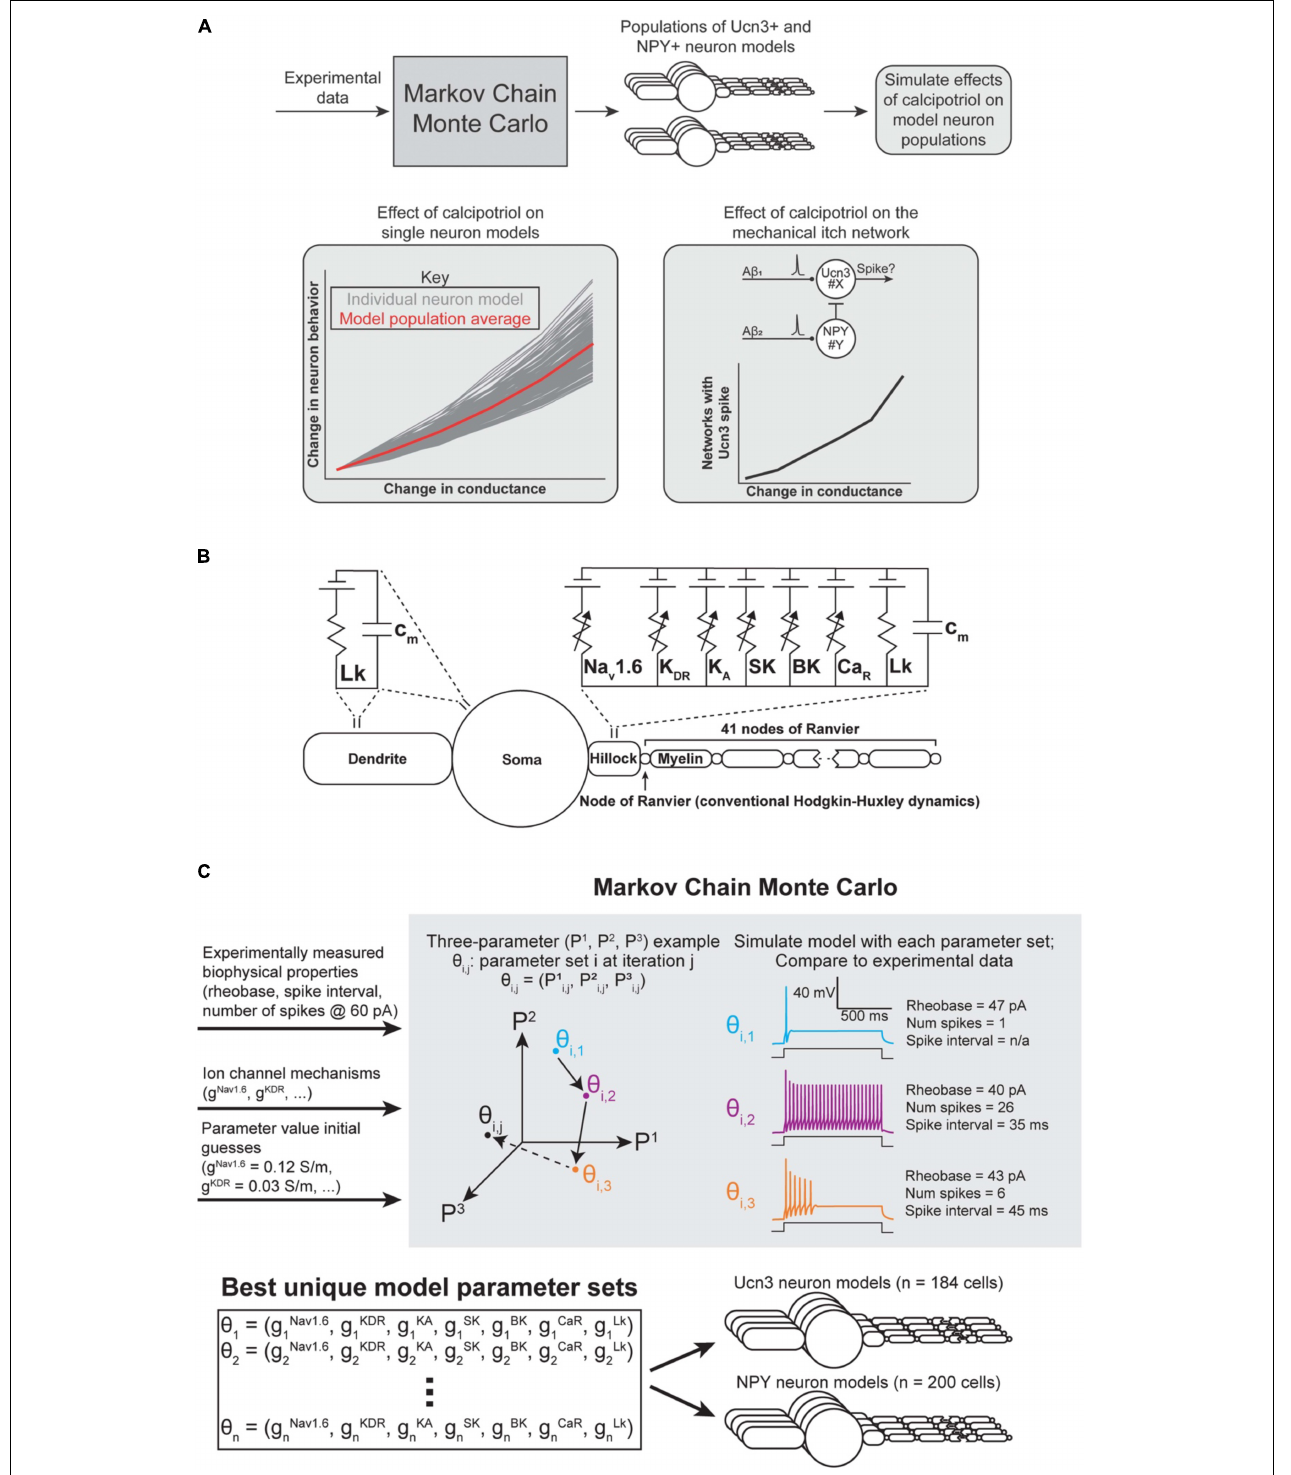
FIGURE 4 | Spinal interneuron model and model population parameterization. (A) Flowchart of computational modeling methods. (B) Multicompartment model of a superficial dorsal horn interneuron expressing the ion channels found to be up- or down-regulated in response to calcipotriol. (C) Markov Chain Monte Carlo (MCMC) method for parameterizing populations of Ucn3 + and NPY + model neurons. An example with three unknown parameters (P1, P2, P3) is shown for visualization purposes. Our implementation of the MCMC algorithm had seven unknown parameters (gNav1.6, gKDR, gKA, gSK, gBK, gCaR, gLk). The MCMC algorithm produced 184 unique models of Ucn3 + neurons and 200 unique models of NPY + neurons.